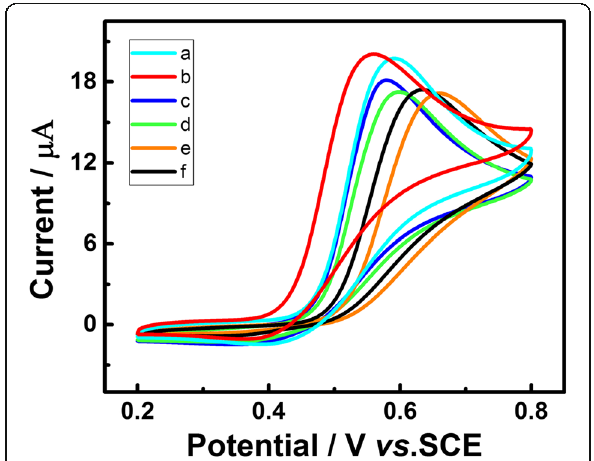
Fig. 4 CVs of Au/GCE electrodeposited with different quantity of gold: 57.8 (a) , 28.9 (b) , 9.6 (c) , 4.8 (d) , 0.96 μ g/cm 2 (e) , and bare GCE (f) in 0.1 M PBS (pH 7.0) solution containing 1.0 mM UA under visible light illumination. Scan rate 50 mV s − 1 . Depositing potential − 0.2